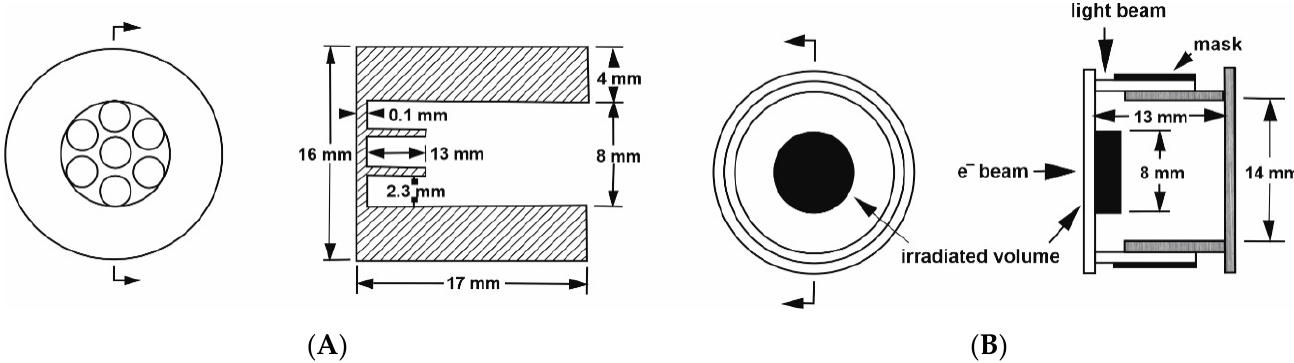
Figure 5. ( A ) Schematic diagram of the electron beam window for high-pressure pulse radiolysis. The electron beam enters from the right side. ( B ) Schematic diagram of the pill-box sample cell, showing the electron beam and light beam paths and the irradiated volume. Reproduced from Reference [22], with the permission of AIP Publishing.